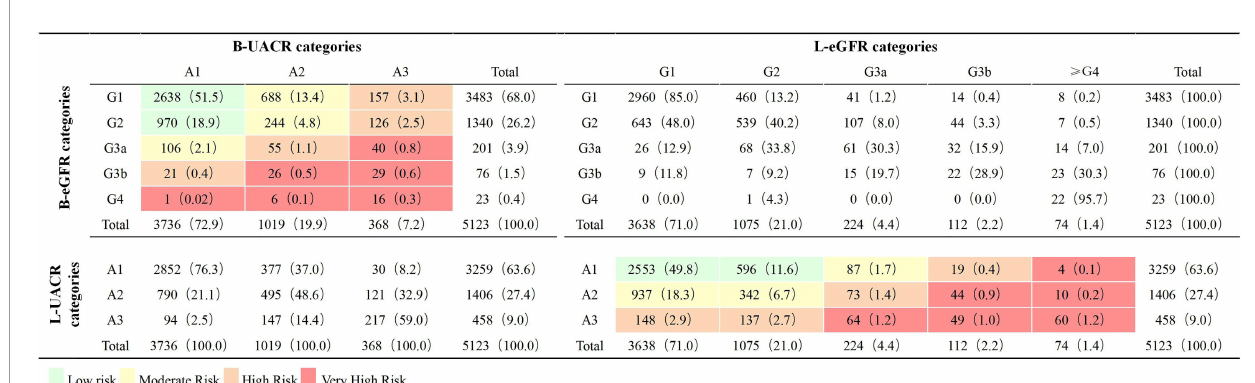
FIGURE 2 | Distribution by eGFR and UACR categories at baseline and Last visit (n = 5123). Classi fi cation is based on KDIGO 2012 Clinical Practice Guidelines for the Evaluation and Management of Chronic Kidney Disease (4). eGFR, estimated glomerular fi ltration rate (mL/min/1.73m 2 ); UACR, urinary albumin-to-creatinine ratio (mg/g); B, baseline; L, last visit. G1, eGFR ≥ 90.0 mL/min/1.73m 2 ; G2, eGFR 60.0 – 89.9 mL/min/1.73m 2 ; G3a: eGFR 45.0 – 59.9 mL/min/1.73m 2 ; G3b: eGFR 30.0 – 44.9 mL/min/1.73m 2 ; G4: eGFR 15.0 – 29.9 mL/min/1.73m 2 ; A1: UACR < 30.0 mg/g; A2: UACR 30.0 – 300.0 mg/g; A3: UACR > 300.0